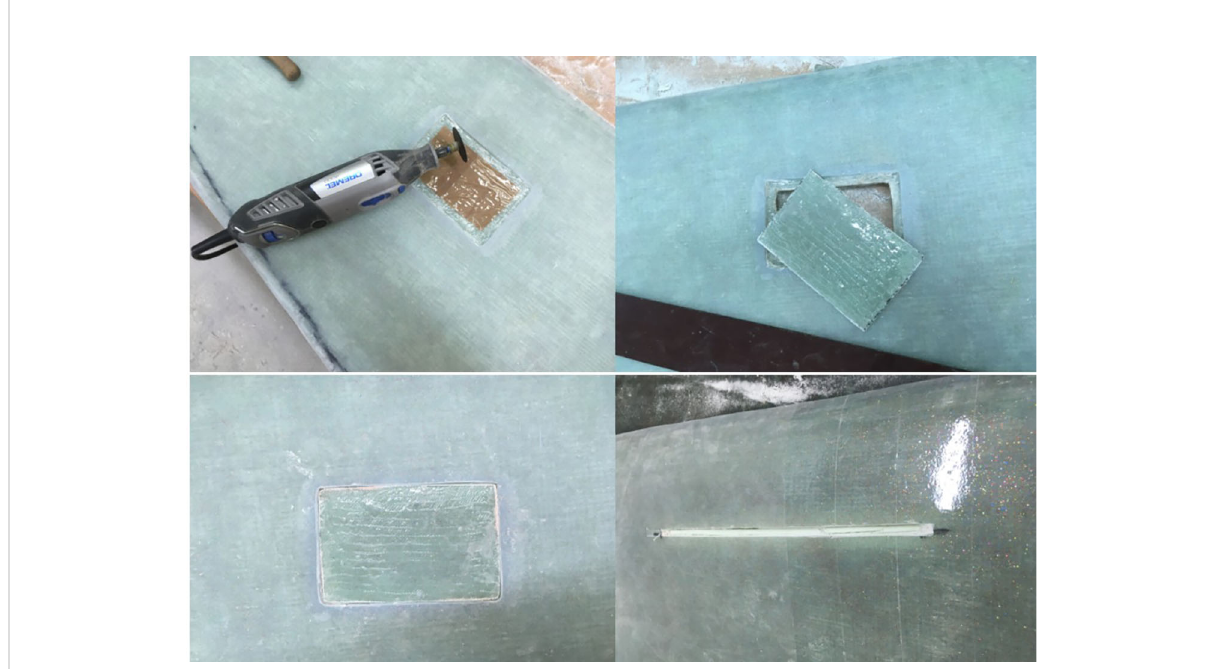
FIGURE 9 Manufacturing of the hatch for the electric components and a rail for the generator